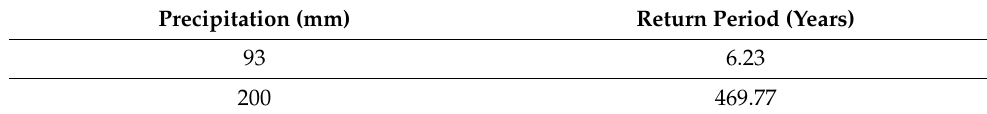
Table 2. Statistical test results of the distributions. Table 3. Return period using Gumbel distribution frequency analysis.